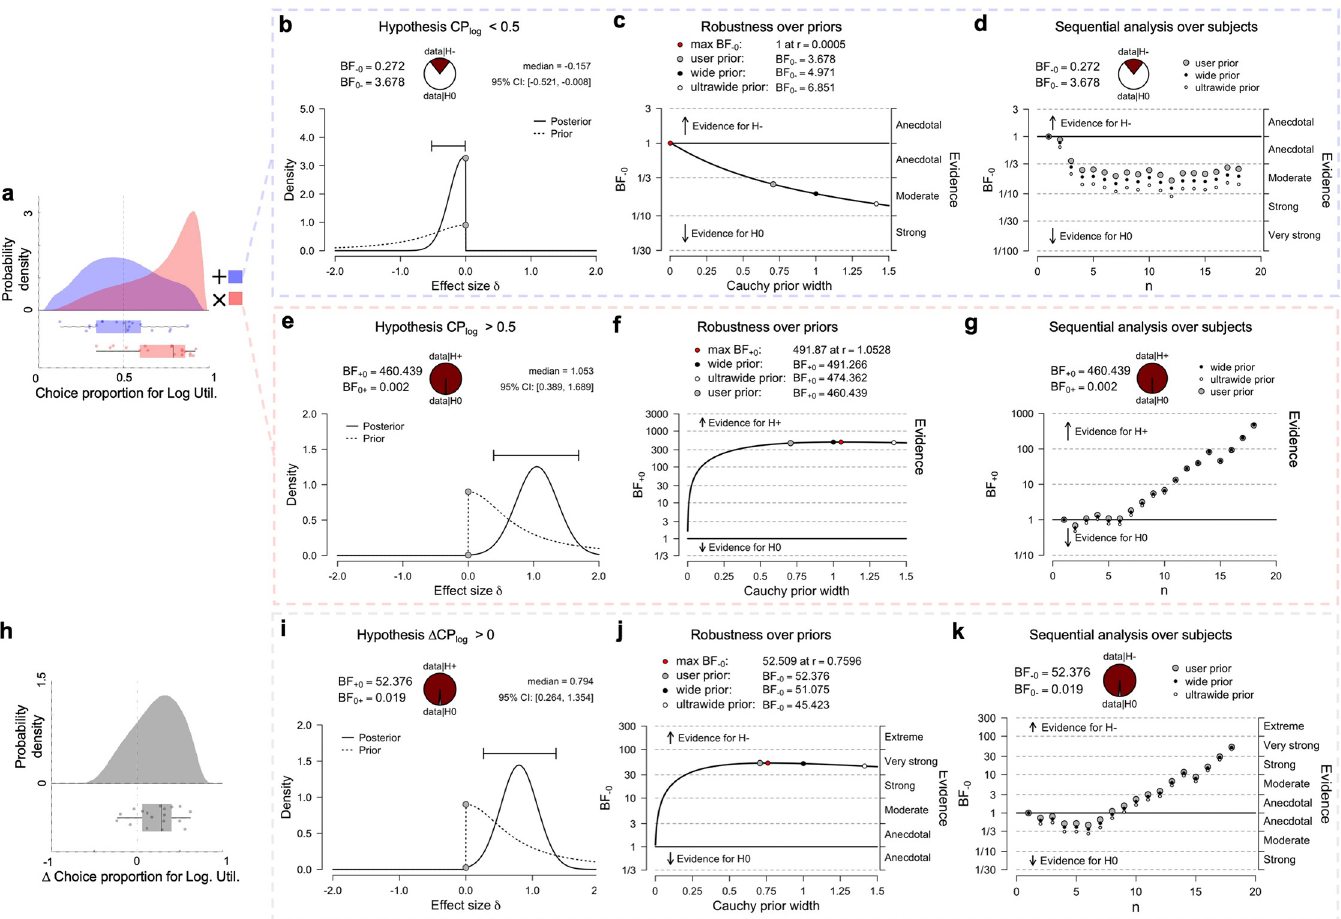
Fig 2. Gamble dynamics affect choice frequencies. A, raincloud plot[18] showing choice proportions in favour of log utility (CP log ), for multiplicative (red) and additive (blue) dynamic with split-half violin plot (top) and raw jittered data of individual subjects’ choice proportions together with box and whisker plot (bottom). All box and whisker plots indicate range, 1st & 3rd quartiles, and median. B, prior and posterior density for the hypothesis that choice probabilities are in favour of linear utility (CP log < 0.5) in terms of effect size, for the additive dynamic (Bayesian t-test), reporting Bayes factor in favour of CP log being lower than 0.5 (negative effect size, indicated by BF -0 ) and its reciprocal in favour of the null hypothesis (BF 0- ) C, robustness analysis of Bayes factors in B, showing that a less informative prior (ultrawide) would increase the Bayes factor in favour of the null hypothesis. D, sequential analysis showing how this Bayes factor changes with increasing numbers of subjects, with the different markers indicating different prior widths. E and G , equivalent analyses for the multiplicative dynamic for the hypothesis that choice probabilities are in favour of log utility (CP log > 0.5). H, raincloud plot of the individual change in choice proportion ( Δ CP log ) where positive numbers indicate an increase under multiplicative dynamics. I, posterior and prior densities for the hypothesis that CP log is larger for multiplicative compared to additive dynamics (Bayesian Paired t-test). J and K, equivalent robustness and sequential analyses for this